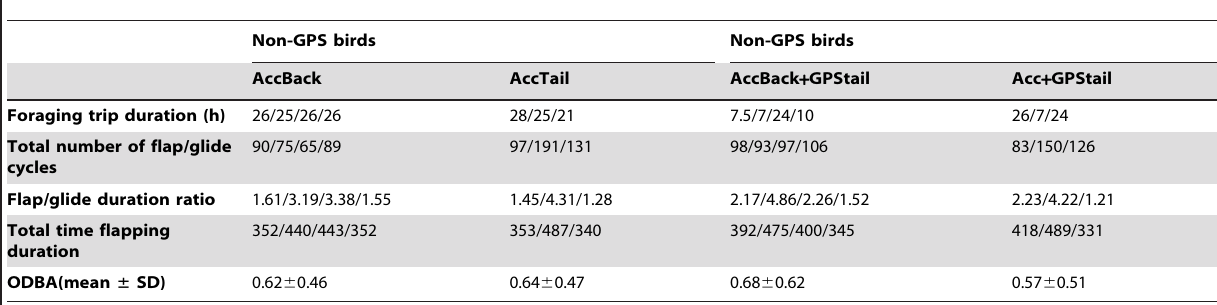
Table 2. Statistics for the flying behaviour of northern gannets ( Sula bassana